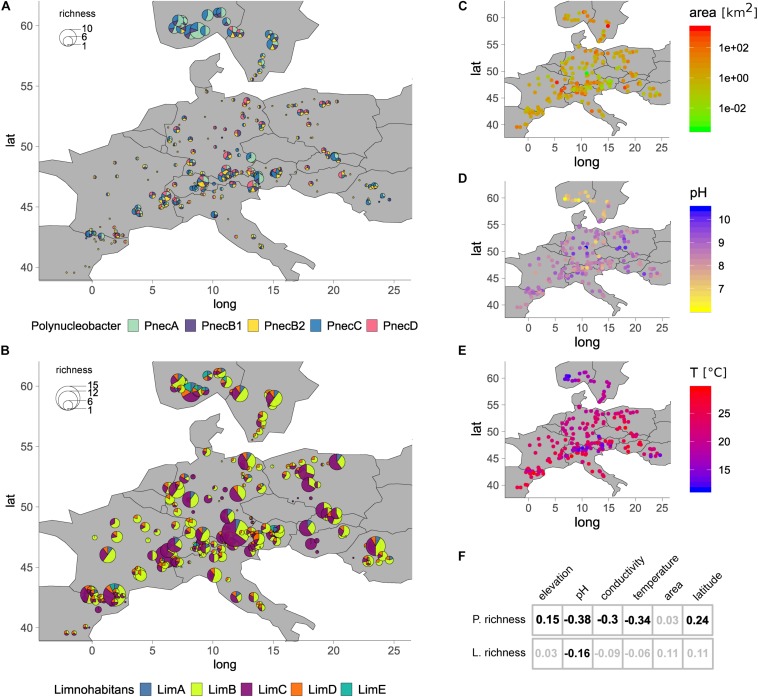
Geographic maps showing the OTU richness of each sample. The OTU richness of (A)
Polynucleobacter and (B)
Limnohabitans is represented by the size of each piechart. Piecharts are divided according to the number of OTUs associated to the different subclusters. The maps in panels (C–E) illustrate lake area, pH and temperature for each sample, respectively. The table in panel (F) shows Spearman rank correlation coefficients of environmental factors with OTU richness of Polynucleobacter and Limnohabitans. Significant correlations (p < 0.05) are shown in black, not significant correlations in gray font. Sites with higher Polynucleobacter OTU richness have lower temperature and acidic to circum-neutral pH.